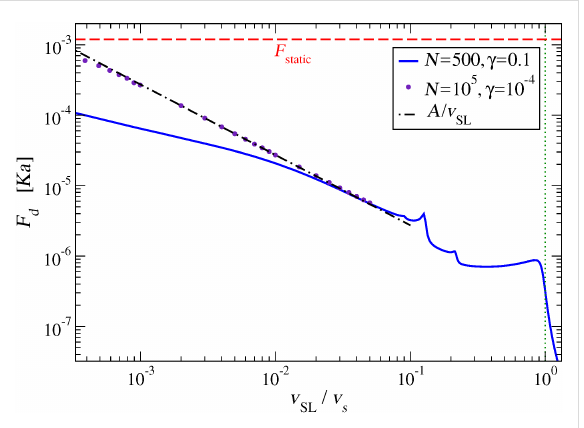
Figure 6: Dynamic friction force as a function of the slider speed v SL . For comparison, the horizontal dashed line marks the static-friction threshold F static obtained in Appendix “The static friction force”, Equa- tion 16. The vertical dotted line marks the speed of sound v s . The data are obtained by means of protocol B; we verified that perfectly super- posable curves can be obtained by means of protocol A as long as it can be effectively applied, i.e., as long as the friction force F d < 10 − 5 Ka